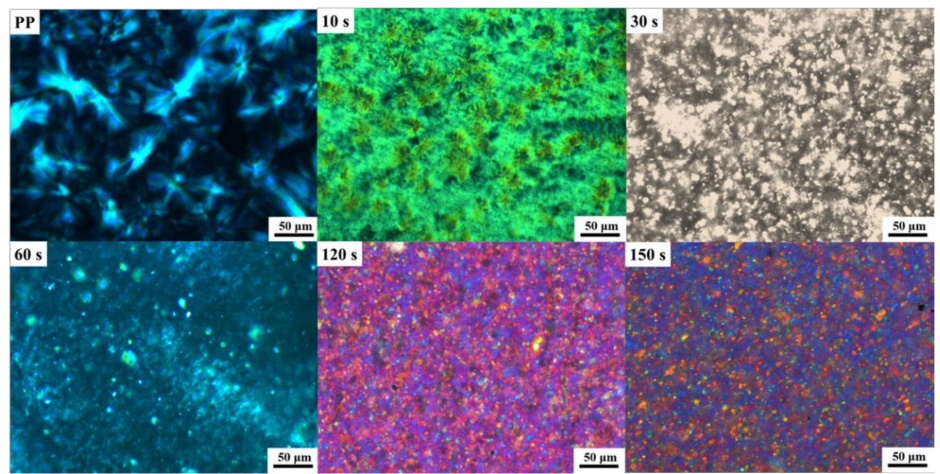
Figure 4. POM diagrams of IIR/PP-TPV samples with different DV times.